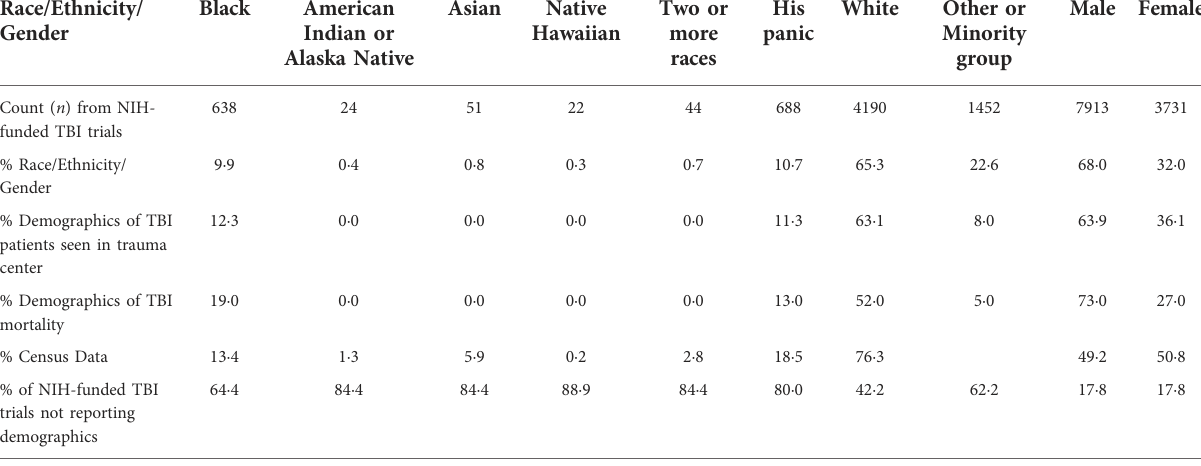
TABLE 1 Demographic reporting from NIH funded TBI clinical